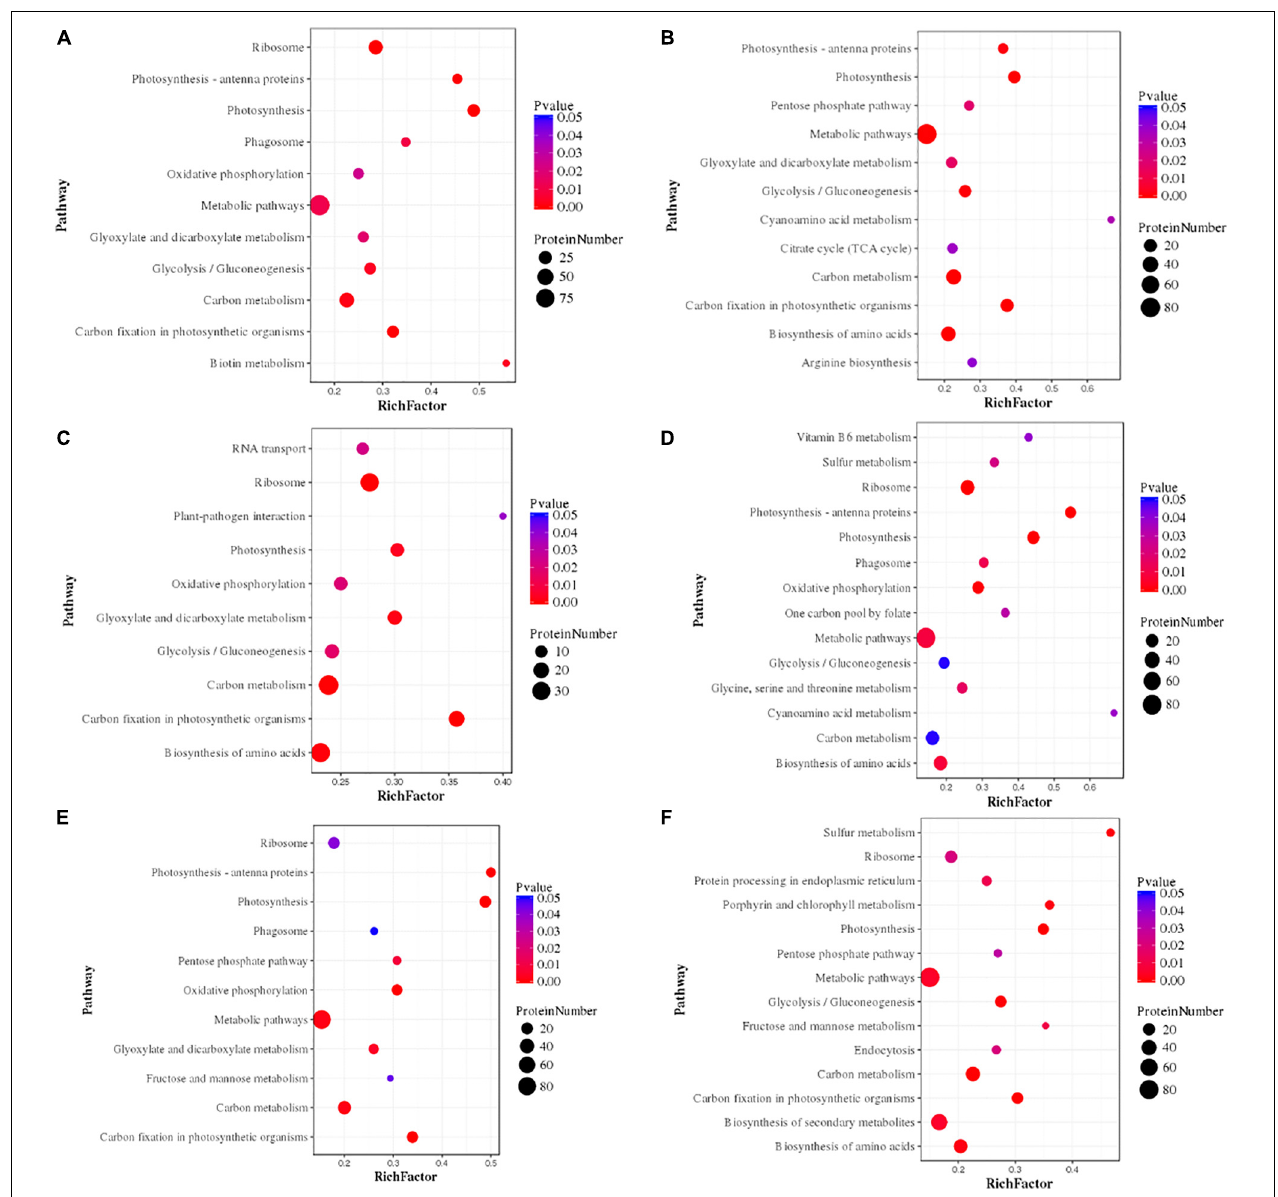
FIGURE 5 | Pathway enrichment analysis of differentially expressed proteins in each pairwise. In the figure greater rich factor means greater intensiveness and p -value ranges from 0 to 1, and less p -value means greater intensiveness. (A) (HTHS-HTLS), (B) (HTHS-LTHS), (C) (HTHS-LTLS), (D) (HTLS-LTHS), (E) (HTLS-LTLS), (F)